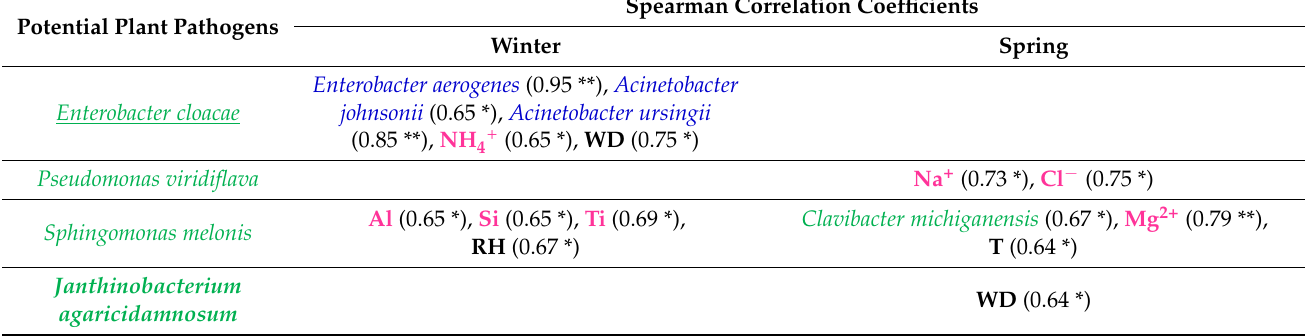
Table 2. Relationships between the most abundant potential and pervasive plant pathogens (green) and with the most abundant and pervasive potential human pathogens (blue), the PM10 (grey) and chemical species (pink) mass concentrations, and meteorological parameters (black) in the winter and spring samples. The related Spearman correlation coefficient is reported in brackets (values significant at a p -level < 0.05 and 0.01 are marked by * and **, respectively). Underlined and bold-italic species represent the ones only found in winter and spring,